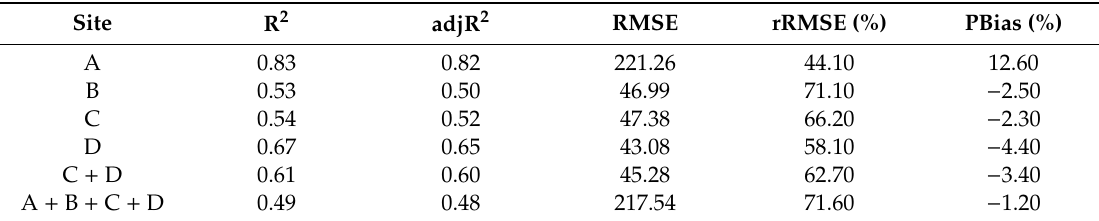
Table 6. Statistic results (R 2 , adjR2, RMSE, rRMSE (%) and PBias (%) calculated for each site (A, B, C, D) and aggregated dataset (C + D and A + B + C +